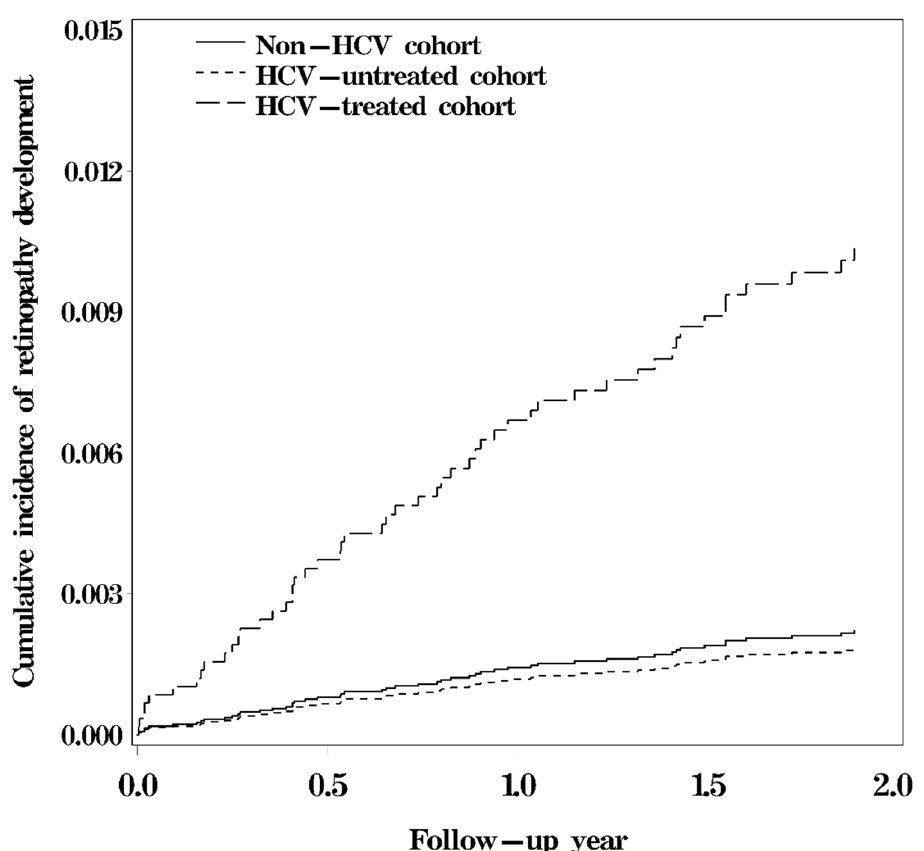
Figure 2. Cumulative risk of retinopathy among the HCV-treated, HCV-untreated, and non-HCV cohorts (log-rank test, p < 0.0001; HCV-untreated cohort vs. non-HCV cohort, p = 0.70; HCV-treated cohort vs. non-HCV cohort, p < 0.0001; HCV-treated cohort vs. HCV-untreated cohort, p = 0.0008).